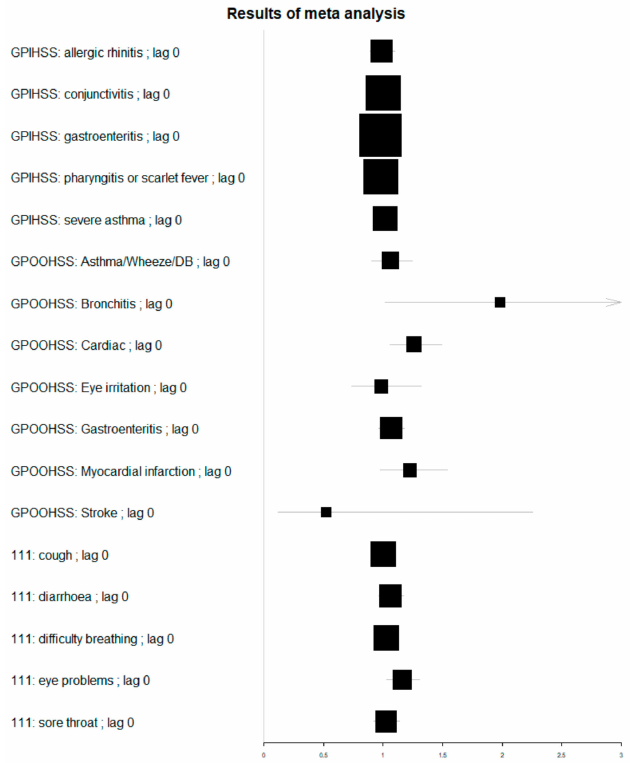
Figure 4. Forest plot of estimates for rate ratio of impact of air pollution on syndromic indicators with a zero lag. Box size is proportional to estimate